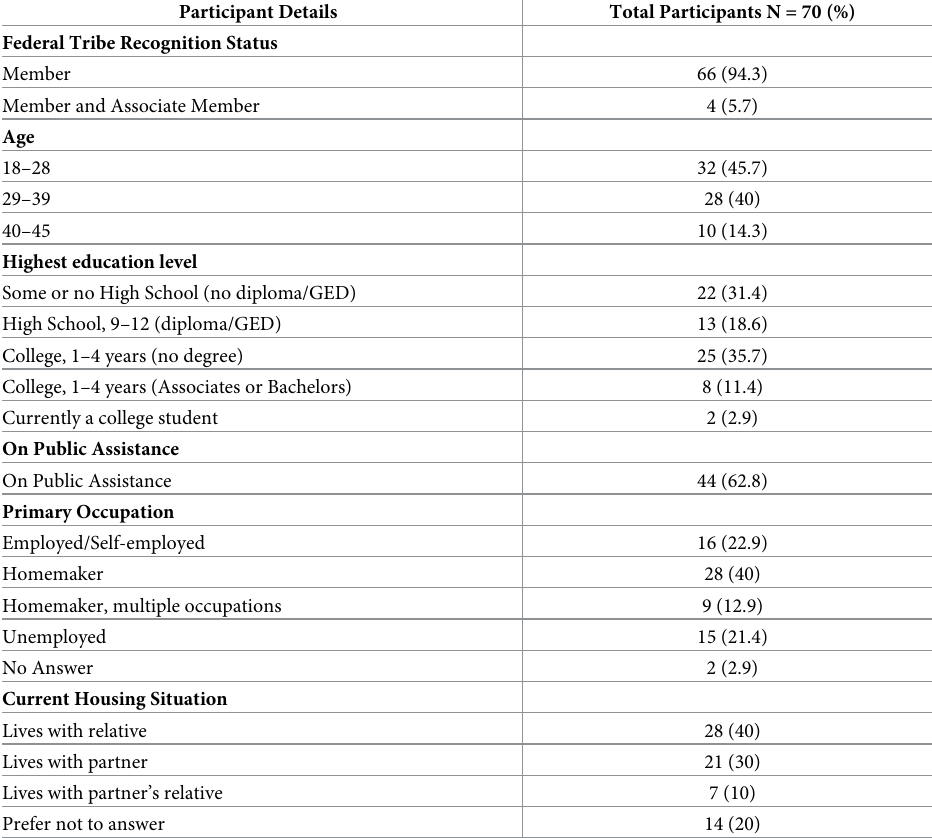
Table 1. Participant